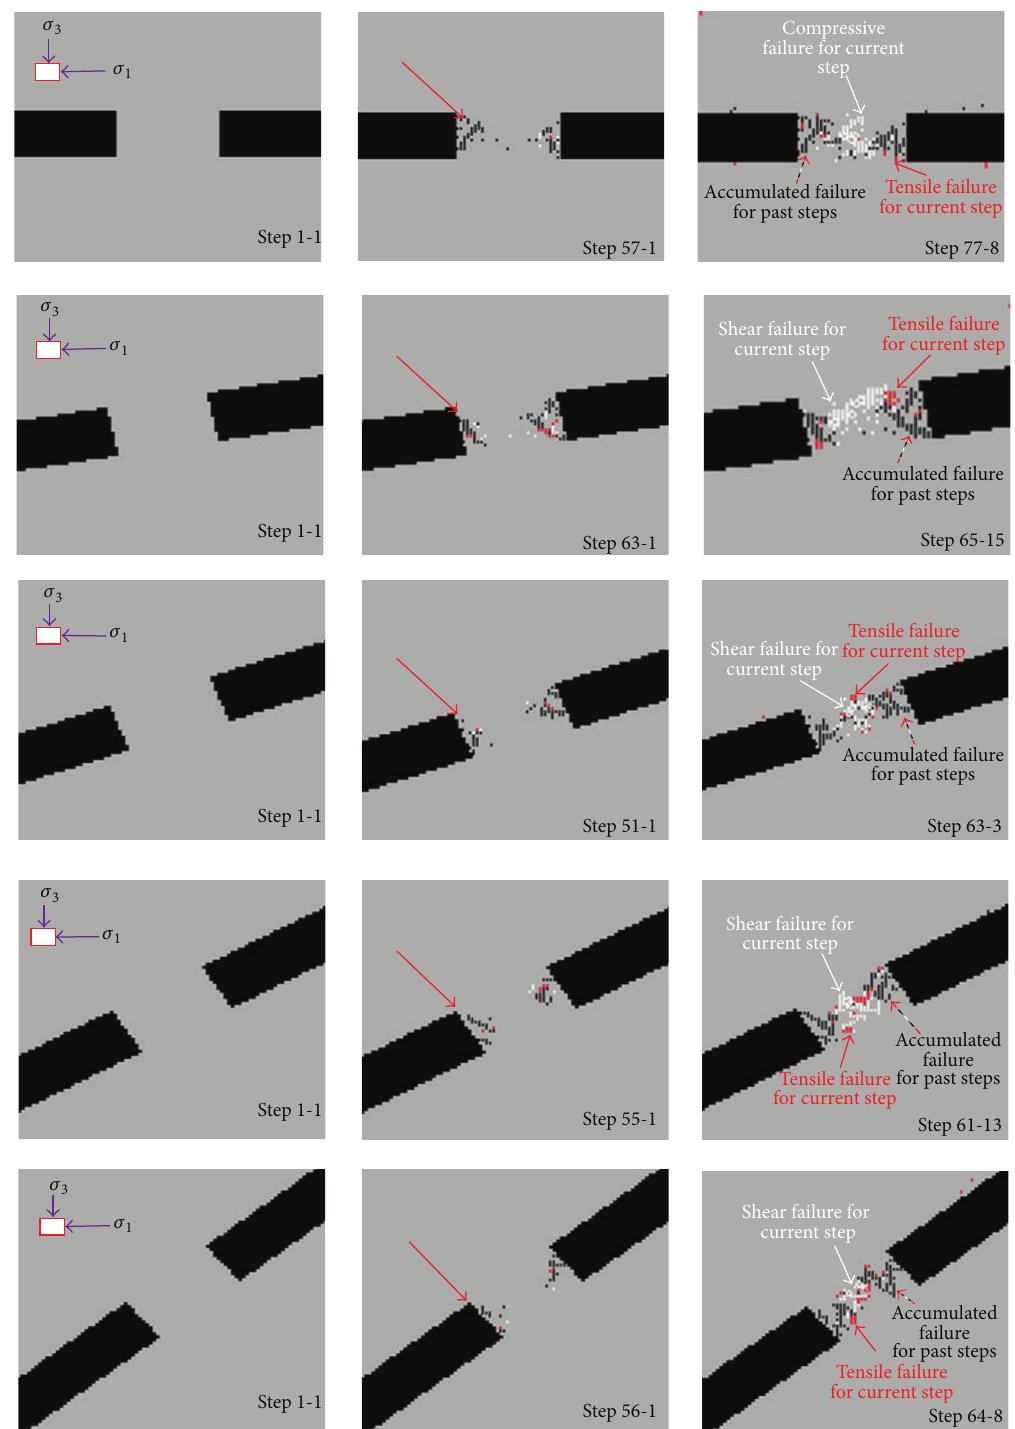
Figure 24: Acoustic emissions in the pillar when the dip angle is between 0 ∘ and 40 ∘